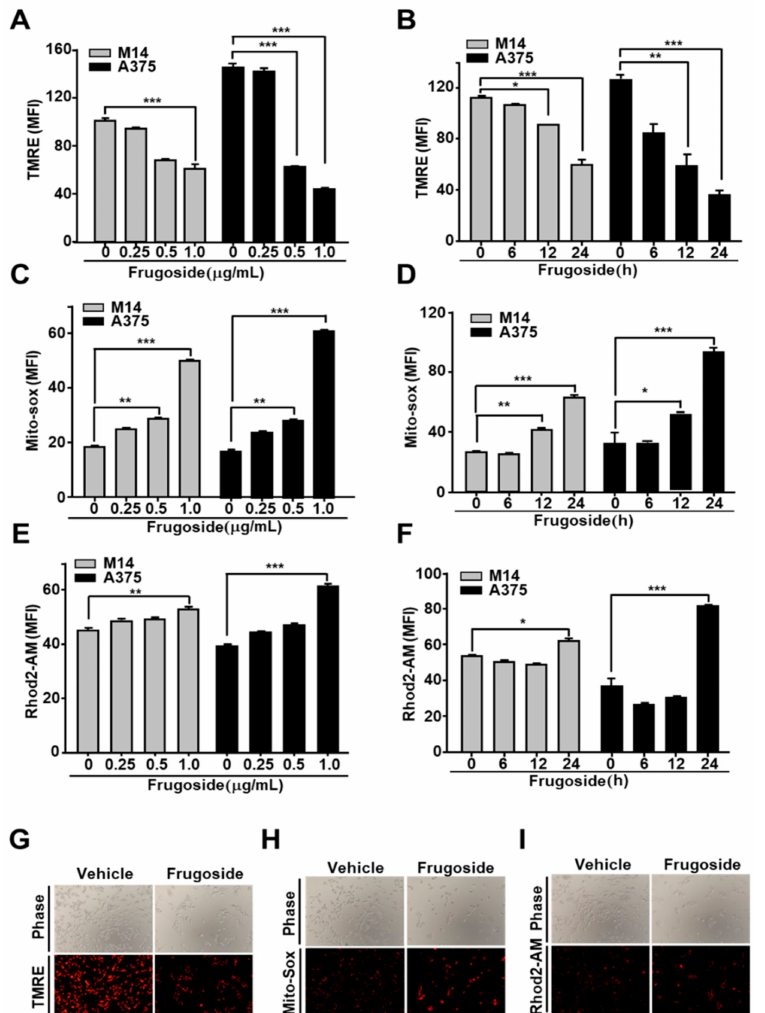
Figure 3. Frugoside results in mitochondrial dysfunction via ROS overproduction. ( A–F ) Melanoma cells were treated with frugoside in dose- (24 h) and time- (0.5 µ g / mL dosage) dependent manners. Stimulated cells were analyzed using flow cytometry for mitochondrial conditions, including the membrane potential, mitochondrial ROS, and calcium overload. The mitochondrial membrane potential was measured using a FACSCanto II apparatus after tetraethylrhodamine ethyl ester (TMRE) staining in M14 and A375 cells treated with various doses of frugoside ( A ) over time ( B ). Mitochondrial ROS was measured in frugoside-treated melanoma cells in dose- ( C ) and time- ( D ) dependent manners via MitoSOX staining. The mitochondrial calcium level was measured using Rhod2-AM fluorescent dye and quantified (dose: E , time: F ). Values are presented as mean ± SD. ( G–I ) Melanoma cells were treated with 0.5 µ g / mL frugoside for 12 h and then stained with TMRE, MitoSOX, and Rhod2-AM dye. The membrane potential ( G ), mitochondrial ROS ( H ), and mitochondrial calcium level ( I ) were also analyzed using fluorescence microscopy. p values were derived to assess statistical significance and are indicated as follows: * p < 0.05; ** p < 0.01; and *** p < 0.001. Original magfication, 100 ×